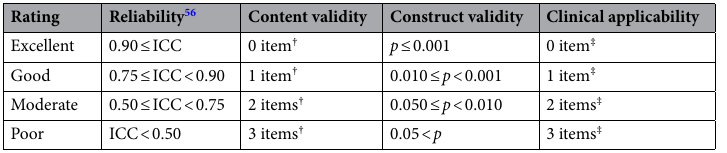
Table 4. Rating used for each measurement property evaluated. † Irrelevant or not sufficiently defined items regarding the construct to be assessed (e.g. population, instrument, parameter, outcome). ‡ Weak items (e.g. cost, simplicity of setup and execution, task-related